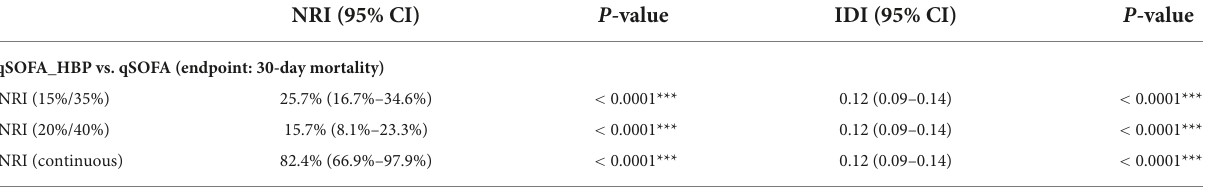
TABLE 4 Net reclassification improvement (NRI) with HBP-modified qSOFA score using 15 and 35% or 20% and 40% as cutoffs to define patient subgroups at low, intermediate, or high risk. NRI (95% CI) P -value IDI (95% CI) qSOFA_HBP vs. qSOFA (endpoint: 30-day